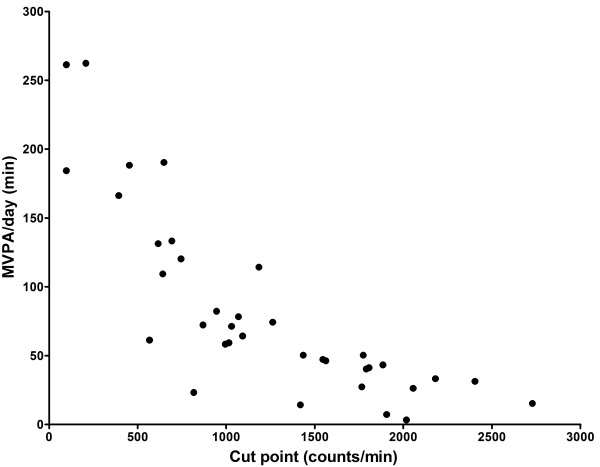
Scatterplot showing the bivariate association between individual cut points and minutes of MVPA/day. Quadratic R2 = 0.791 (p<.001).